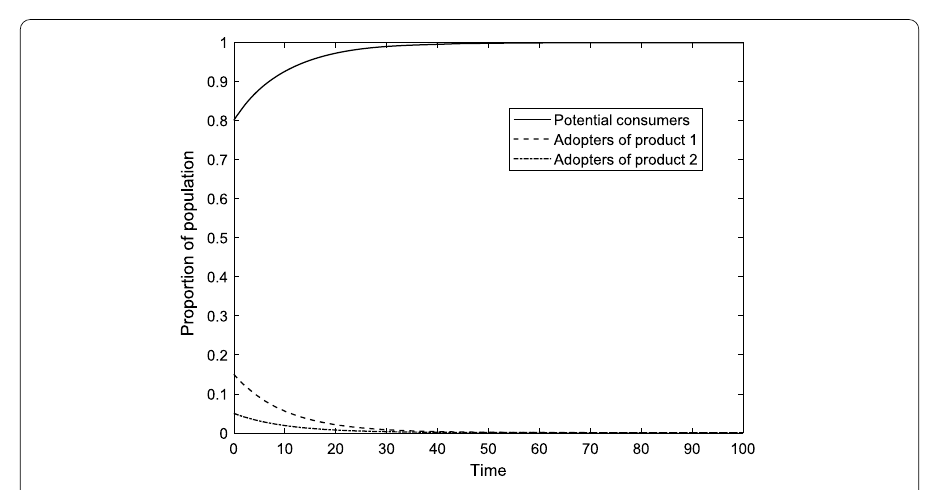
Figure 6 Two competitive products fail to diffuse with considering advertising